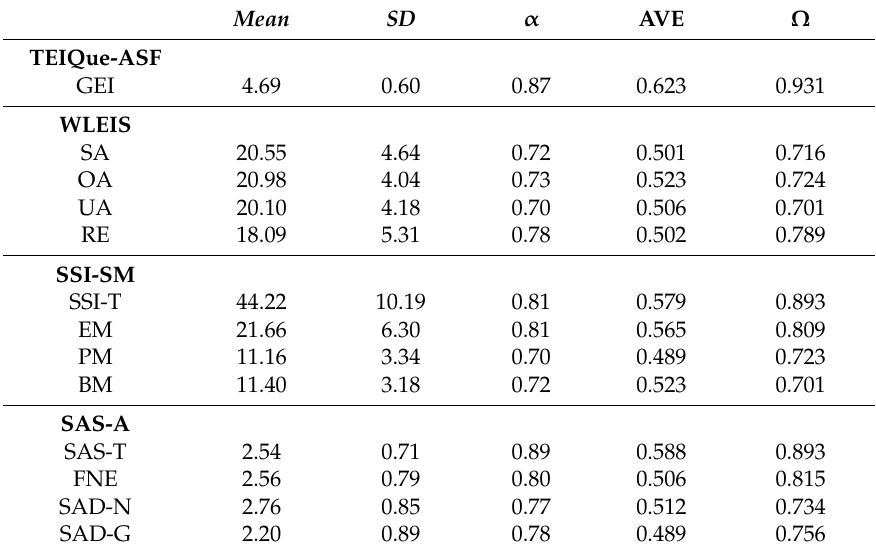
Table 2. Descriptive statistics of the variables under study and reliability evidence of the instruments used ( n = 505). AVE—average variance extracted; SD —standard deviation.